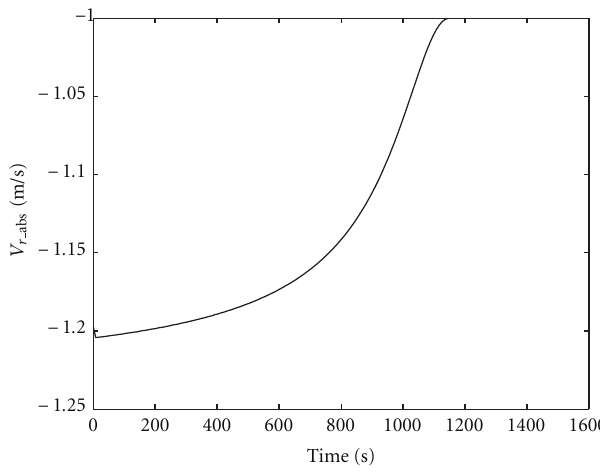
Figure 6: Velocity of the robot in Z l direction considering a linear sea current